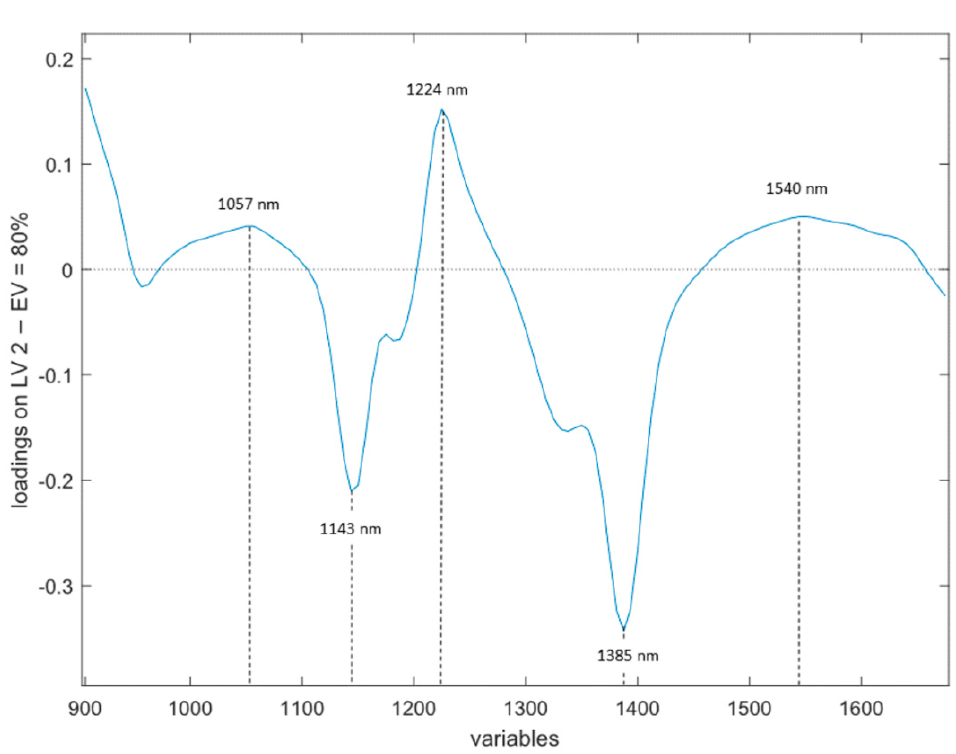
Figure 2. Loadings of LV1 ( A ) and LV2 ( B ) in BIA.